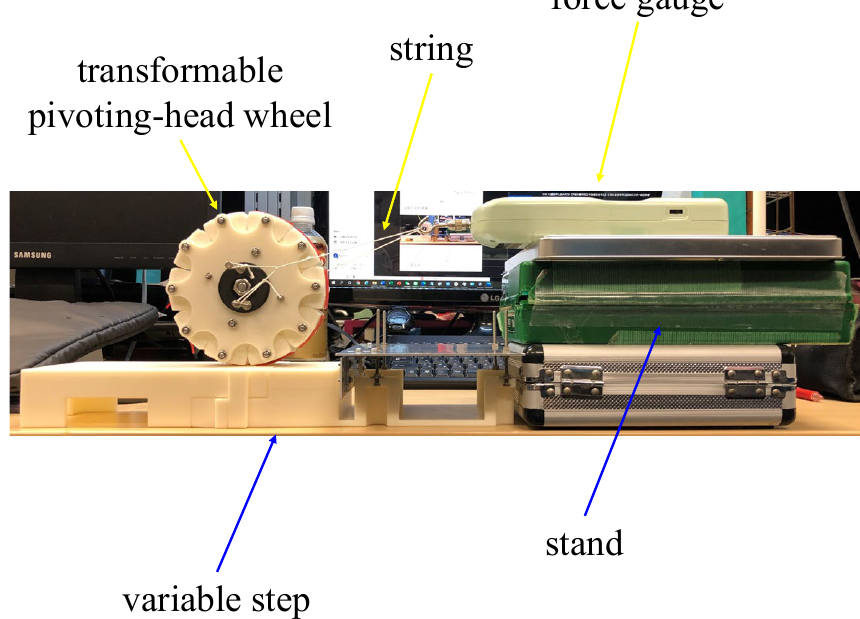
Figure 18. Experimental environment for measuring the force to overcome a step.